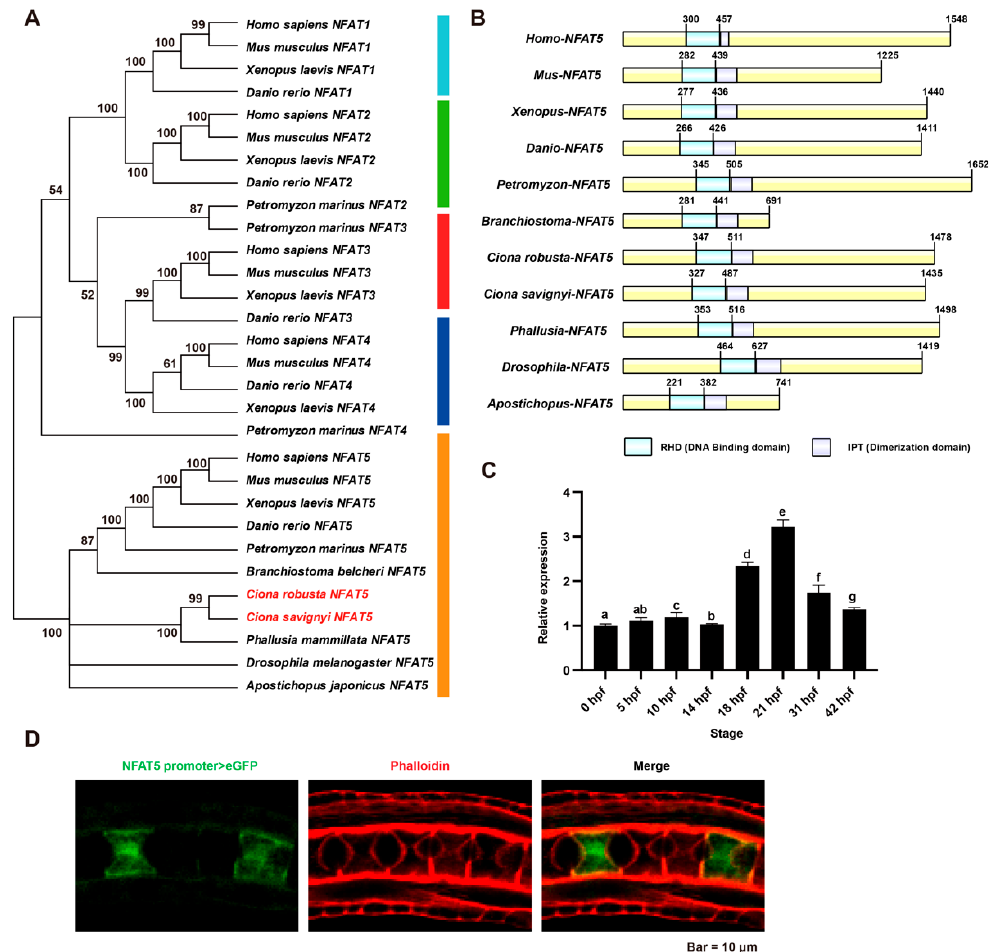
Figure 1. Evolutionarily analysis, the conserved domain alignment, mRNA expression profile analysis, and tissue expression pattern of NFAT5 . ( A ) The phylogenetic tree of NFAT family genes was constructed by the maximum likelihood method. The LG model for amino acid substitution was used. The color strip denotes the cluster of NFAT1, NFAT2, NFAT3, NFAT4, and NFAT5. The red font highlighted Ciona NFAT5. ( B ) Schematic diagrams of the domain organization of all NFAT5 sequences. Light blue and light purple indicate conserved RHD (DNA binding domain) and IPT (Dimerization), respectively. ( C ) Expression profile of Ci-NFAT5 from 0 to 42 hpf. There appears to be a high expression level at 18 and 21 hpf when the lumen is expanded. Significance difference is marked by letters (a-g). The identical letter indicates that the difference is not significant, whereas the different letter indicates the difference is significant. ( D ) The tissue expression pattern of NFAT5 by promoter assay. The fluorescence was observed in the notochord at the lumen expansion stage. We explored the expression profiles of Ci-NFAT5 at different embryonic and larval stages (0, 5, 10, 14, 18, 21, 31, 42 h postfertilization, hpf) by qRT-PCR. The results showed that the expression level of Ci-NFAT5 increased from 14 to 21 hpf when the notochord lumen started to format and expand, then decreased from 31 to 42 hpf (Figure 1C), indicating that NFAT5 plays roles during lumen formation. Then, to determine the tissue expression pattern of Ci-NFAT5 , we made an NFAT5 promoter construct, which included 3054 bp upstream of NFAT5 and expressed it in Ciona embryos. The fluorescence was observed to be expressed in the notochord at the lumen formation stage (Figure